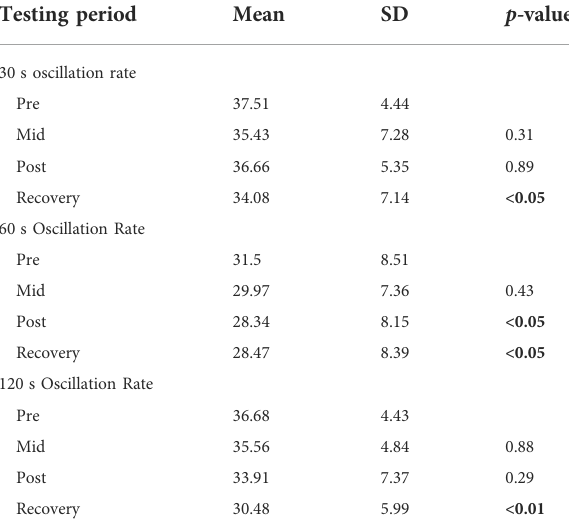
TABLE 8 Thein fl uenceof30 s,60 s,and120 soscillationsof80/20and 30/70 O2/N2 concentrations on arterial partial pressure of carbon